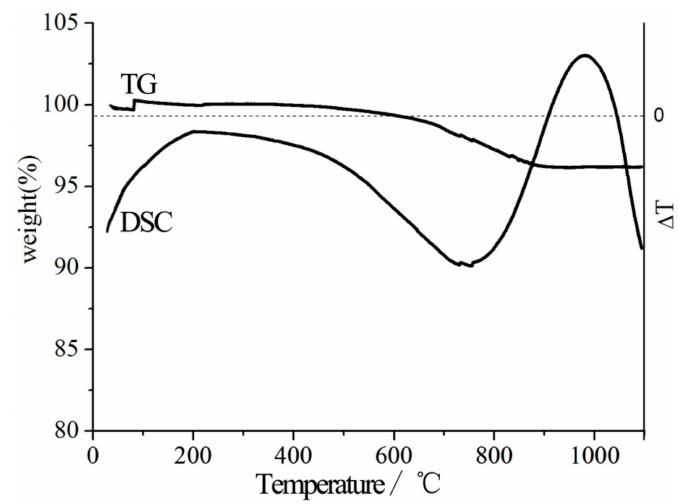
Figure 1. TG and DSC curves of S 0